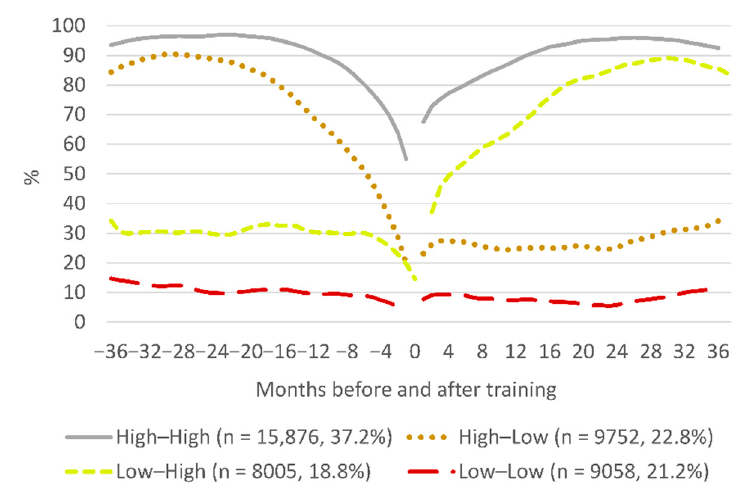
Figure 1. Trajectory groups of work participation in the open labour market before and after voca- tional labour market training.